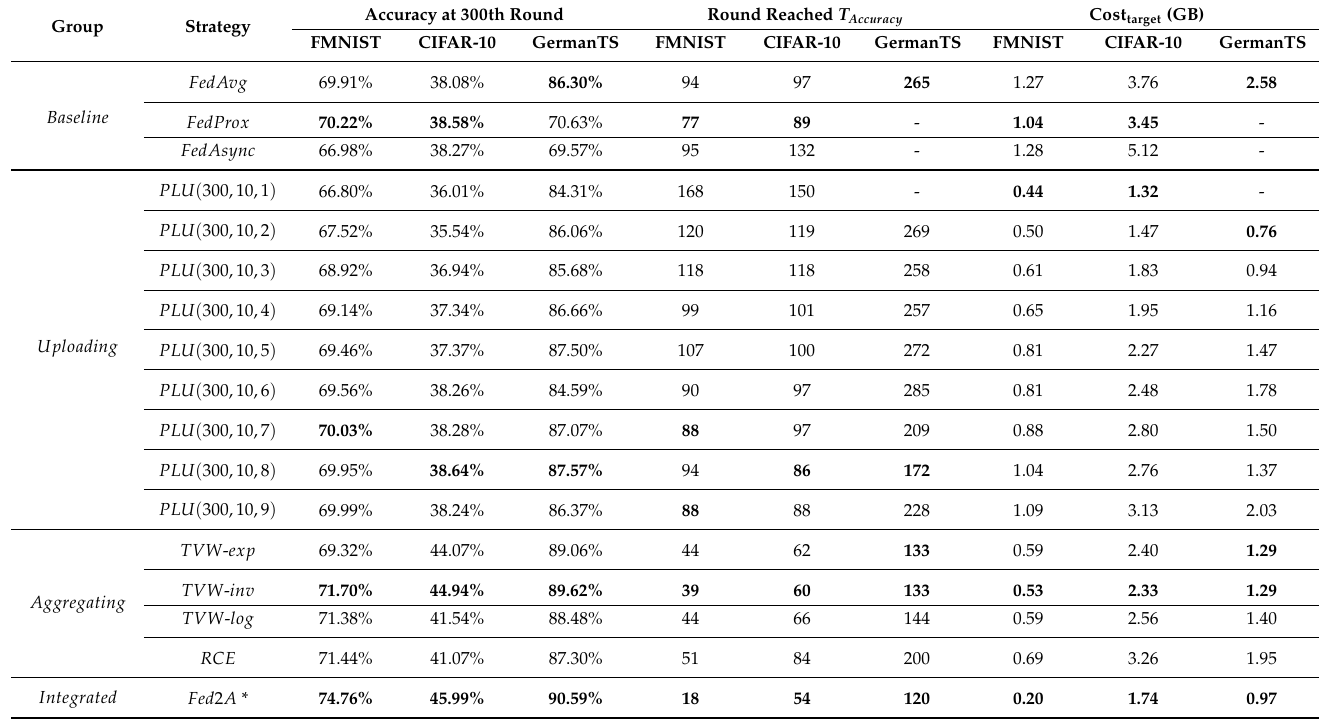
Table 4. Summary of experiment